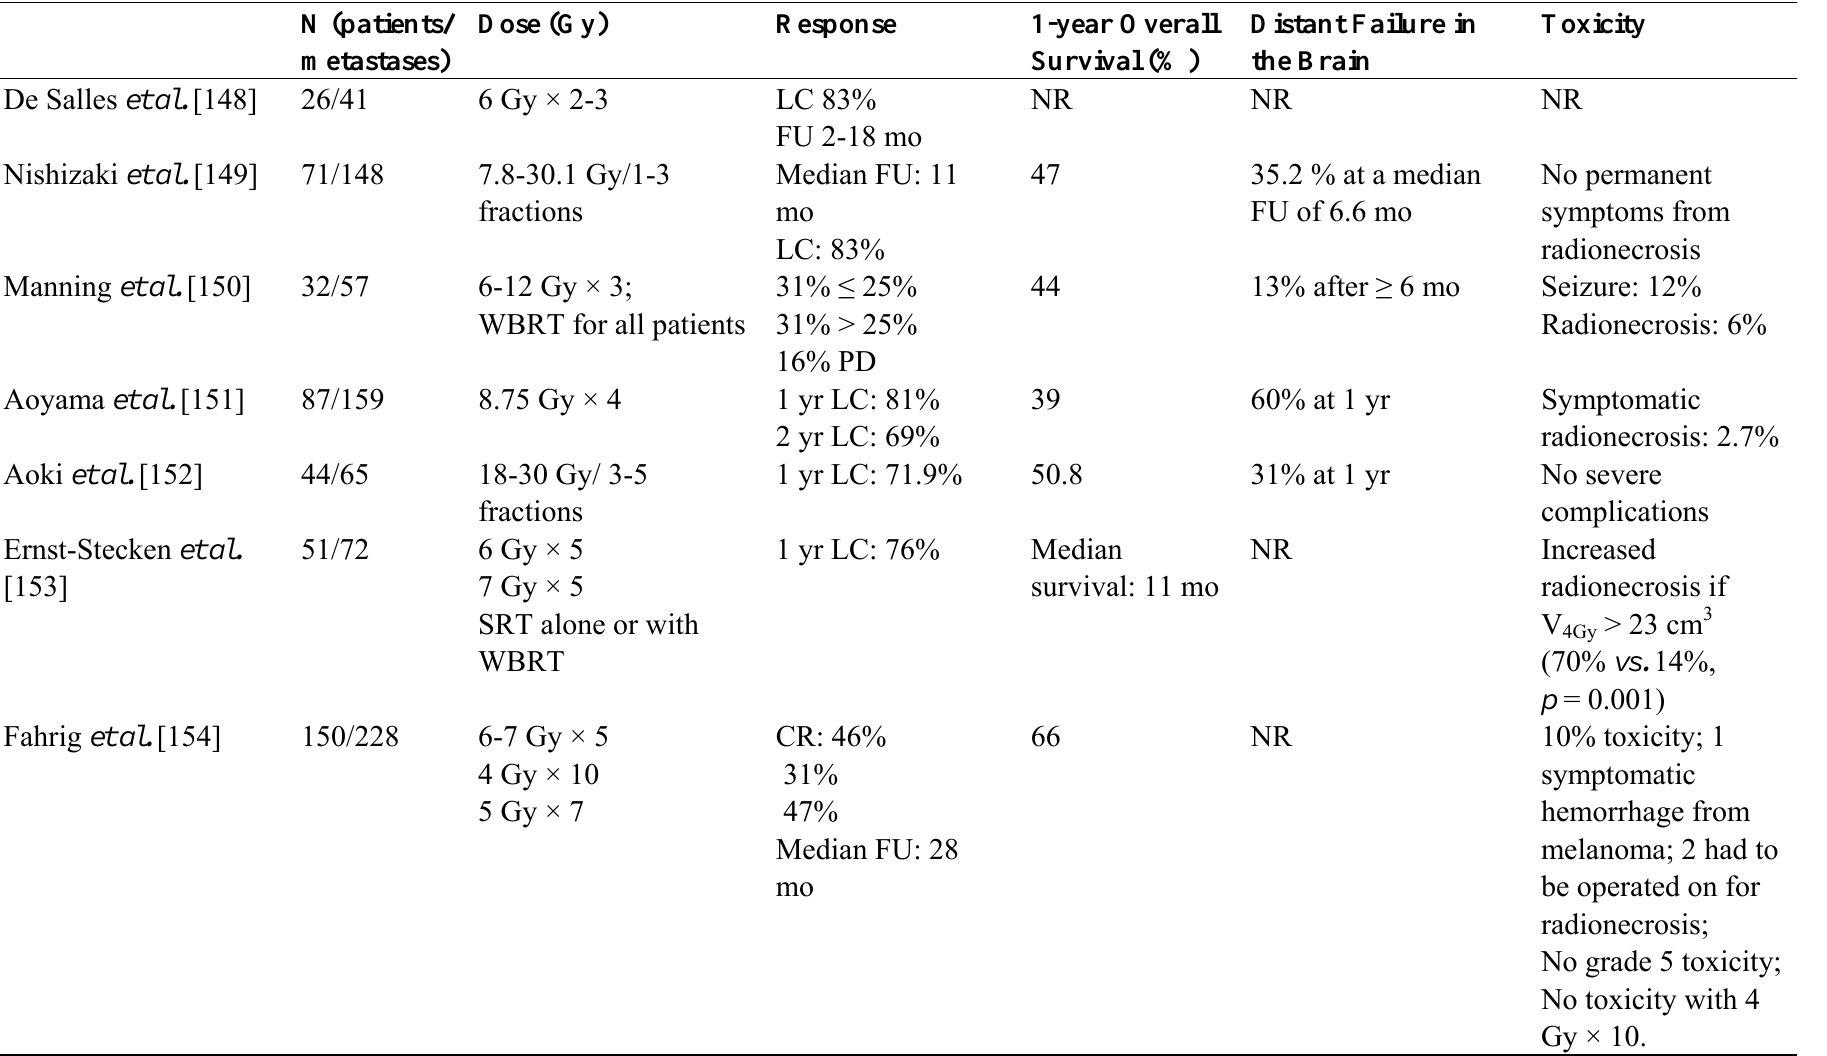
Table 10. Selected studies of fractionated stereotactic